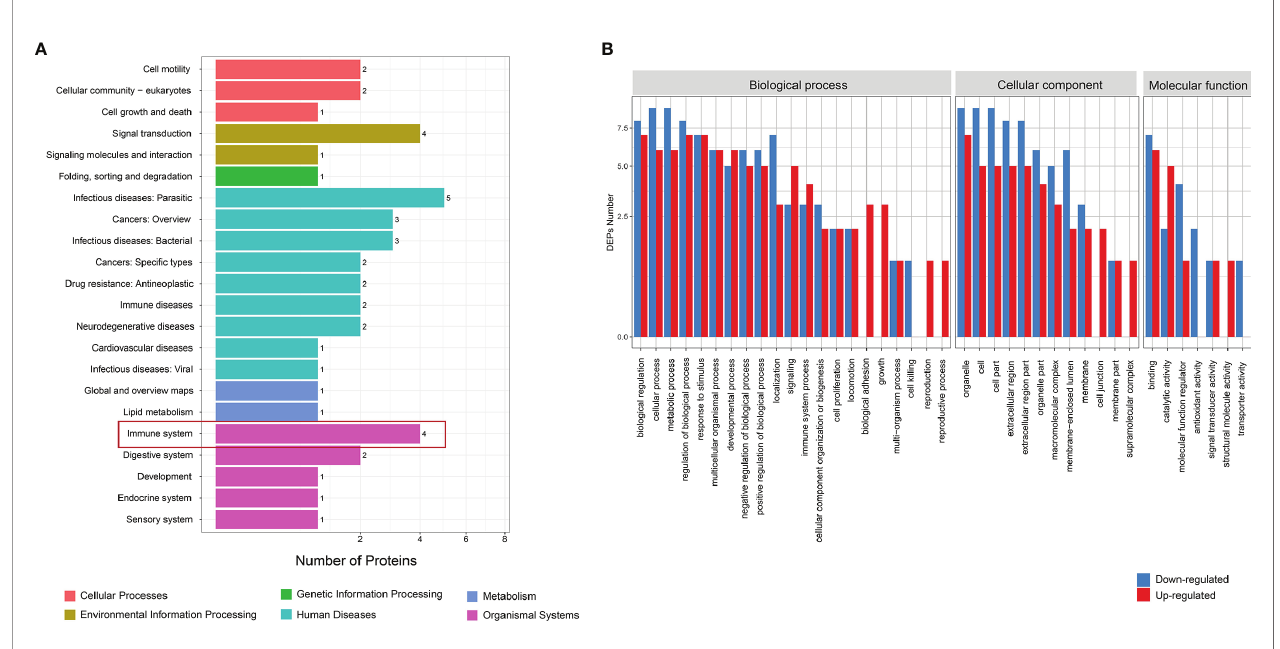
FIGURE 3 | Function analysis of differential proteins between HT and NC groups. (A) KEGG enrichment analysis. (B) GO analysis for upregulated and downregulated proteins. HT, Hashimoto ’ s thyroiditis; NC, normal control; KEGG, Kyoto Encyclopedia of Genes and Genomes; GO, Gene